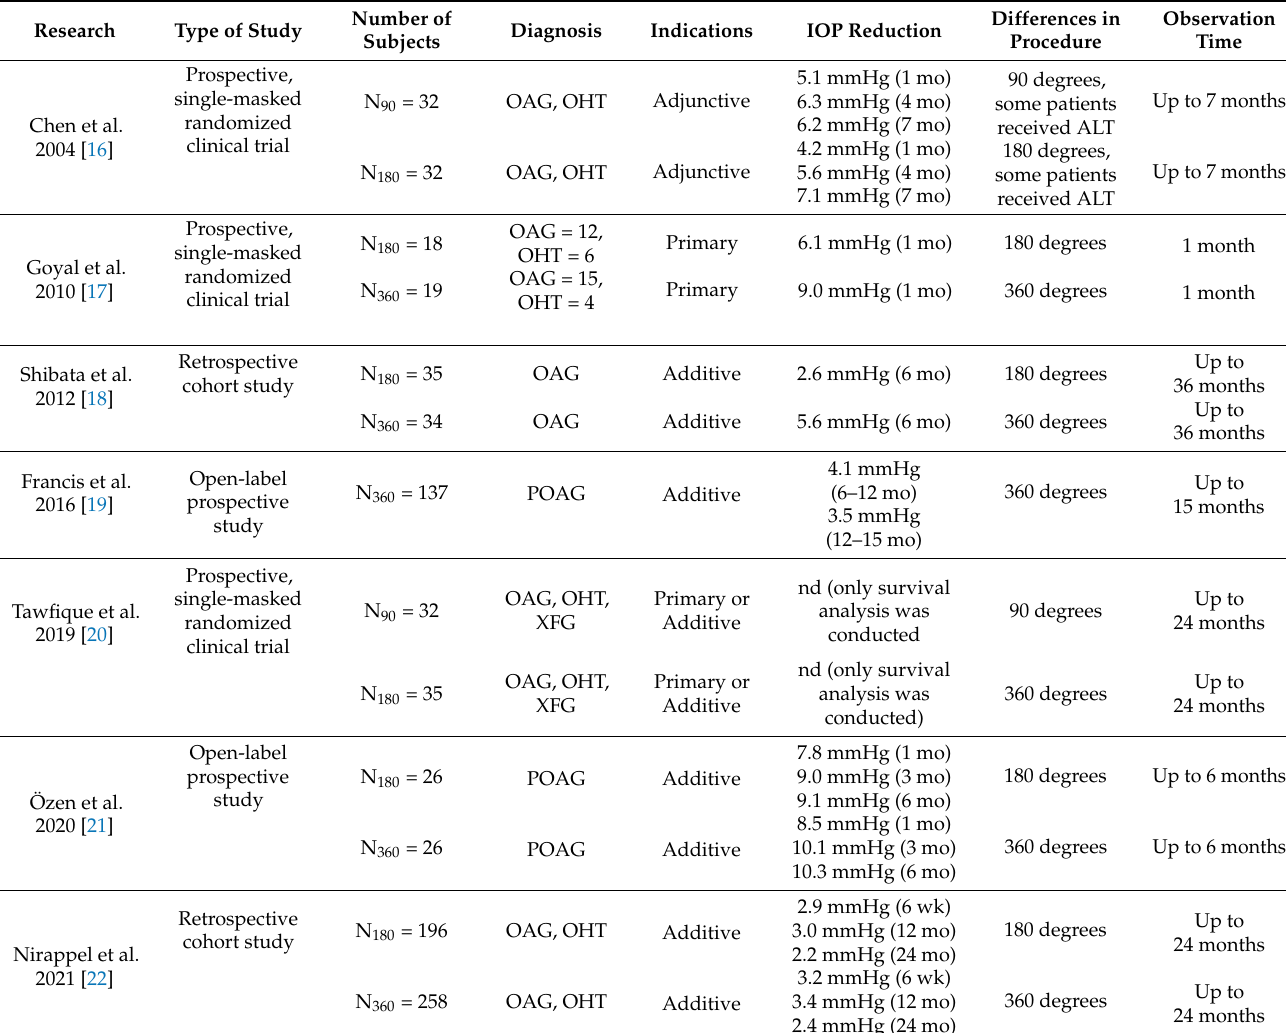
Table 1. Summary of the effectiveness of SLT in relation to the scope of the procedure performed (the number of quadrants of the circuit covered by laser